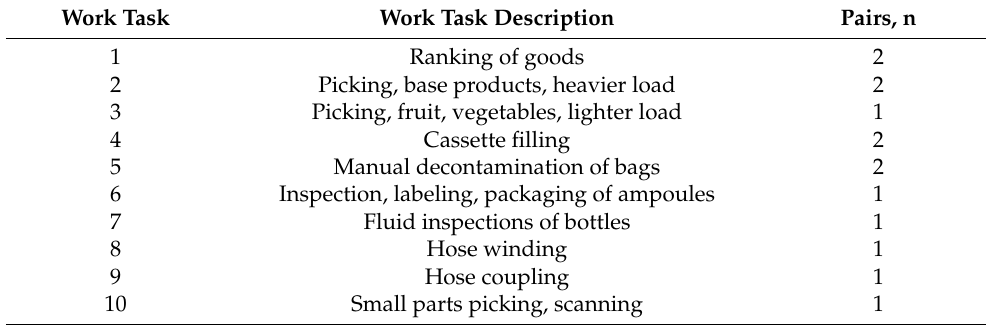
Table 1. The identified work tasks with various hand-intensive exposures. Each pair consisted of a woman and a man who performed the identical hand-intensive work task. There were 28 pairs in